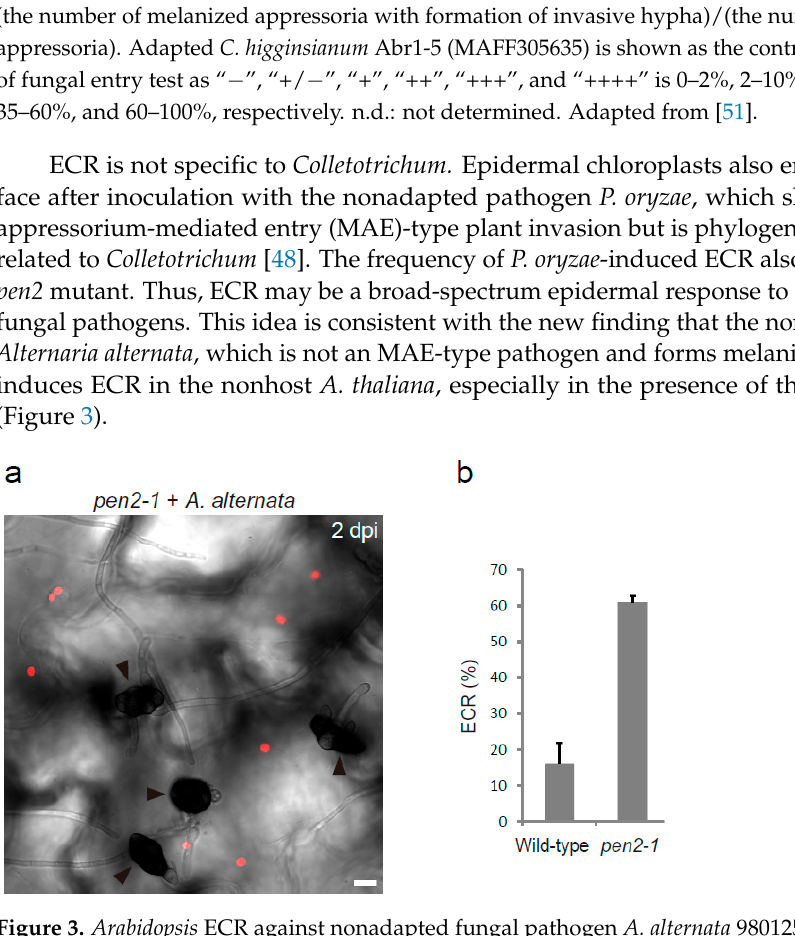
Figure 3. Arabidopsis ECR against nonadapted fungal pathogen A. alternata 98012501 (MAFF712212). ( a ) The epidermal surface of the pathogen-inoculated cotyledon of pen2-1 mutant was observed at 2 dpi. The chloroplasts were visualized based on chlorophyll autofluorescence. The DIC image was captured by confocal microscopy. The arrowheads indicate melanized conidia. Scale bar, 10 µm. ( b ) Quantification of the ECR in the wild-type and pen2-1 plants. The ratio of epidermal cells with surface chloroplasts was investigated at 2 dpi. A total of 100 cells in contact with the pathogen were observed. The means and SE were calculated from three independent plants.